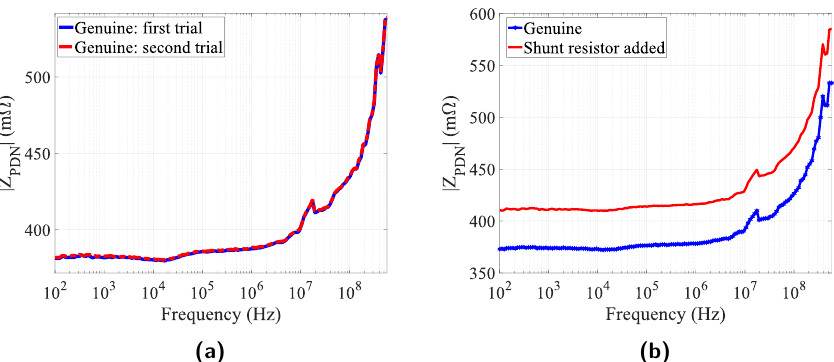
Figure 5: The mean of 105 impedance measurements over the frequency band of 100 Hz - 588 MHz (a) An untouched sample (intra-genuine measurements). (b) The board with added 10 mΩ shunt